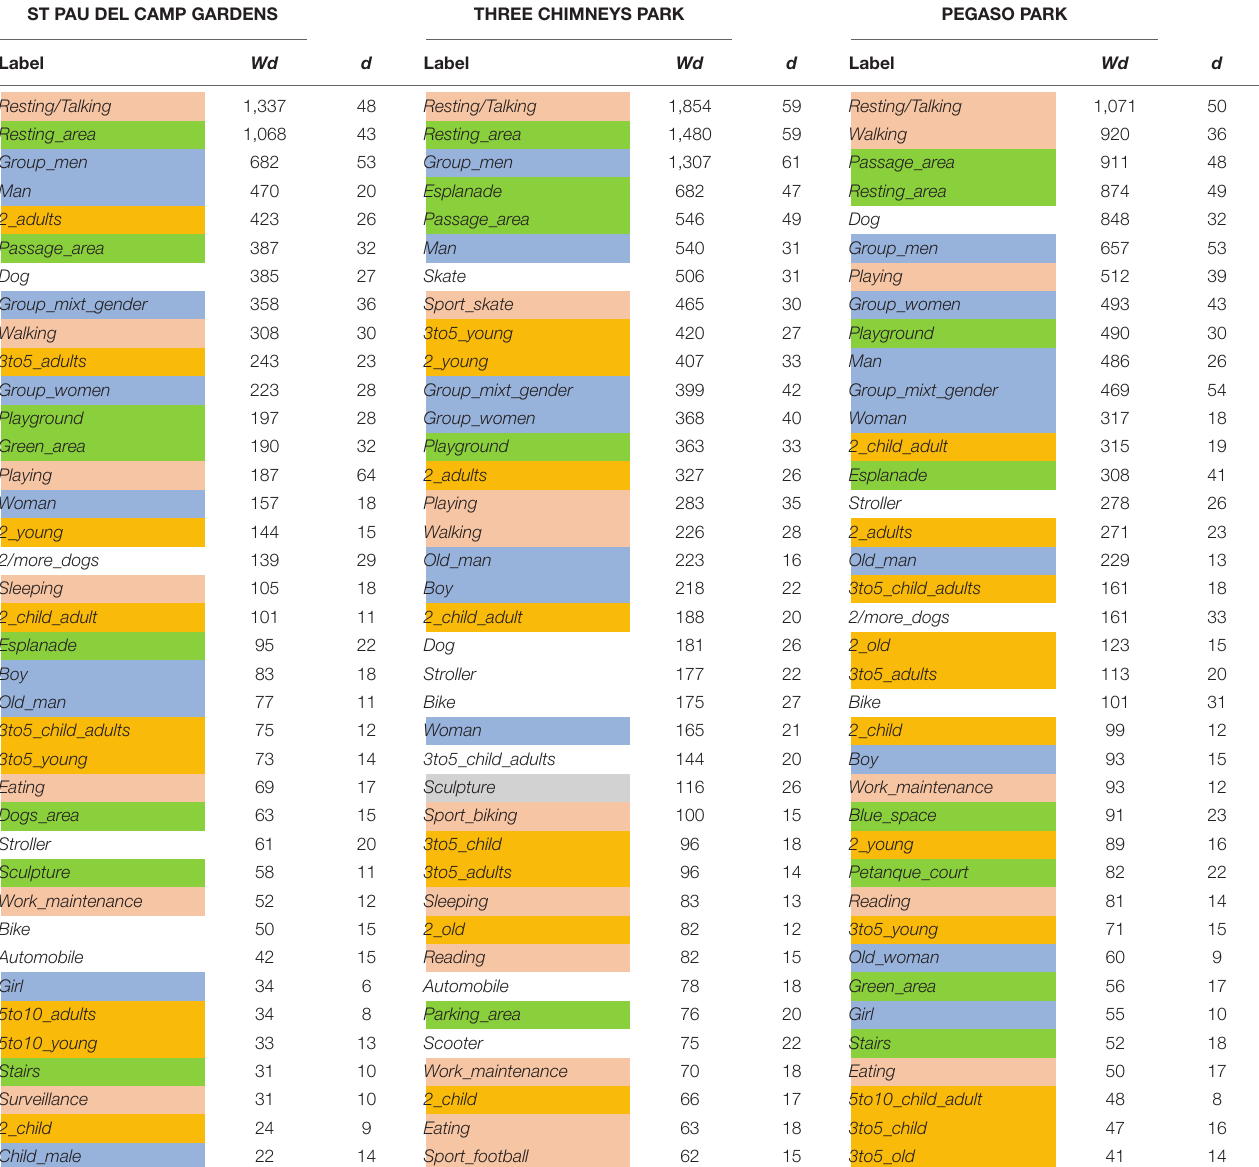
TABLE 3 | Weighted Degree ( Wd ) and Degree ( d ) of the 40 main nodes per case study network. ST PAU DEL CAMP GARDENS THREE CHIMNEYS PARK PEGASO